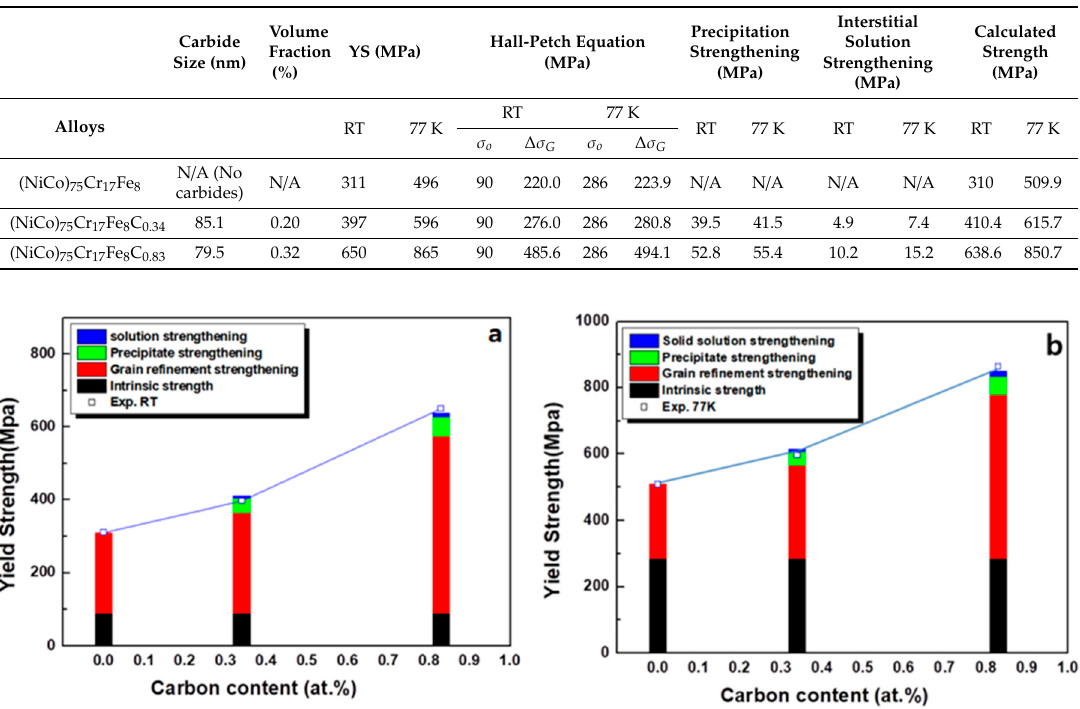
Table 3. Strength contributions from di ff erent strengthening mechanisms of the annealed carbon-free and carbon-containing (NiCo) 75 Cr 17 Fe 8 C x medium-entropy alloys (MEAs). (N / A: not applicable).